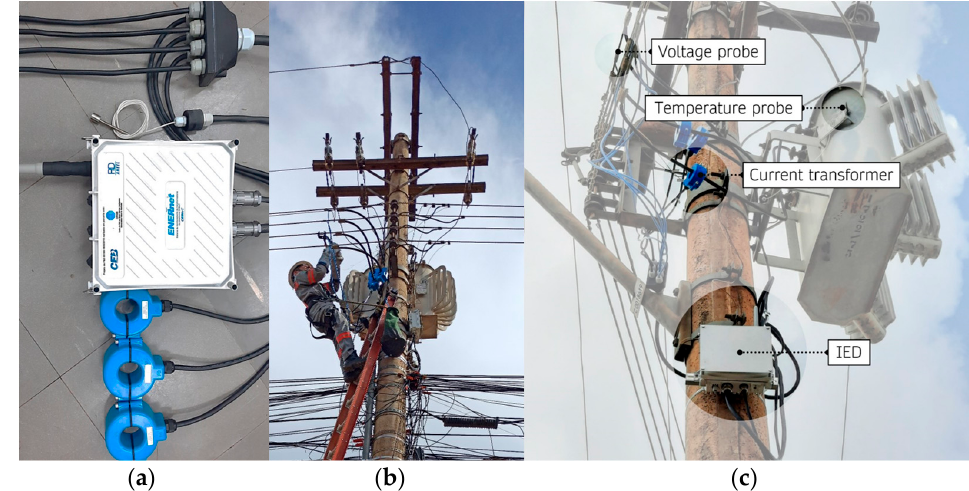
Figure 1. Monitoring system of distribution transformers used to perform basic electrical and thermal measurements of the transformer. ( a ) IED (intelligent electronic device). ( b ) Non-intrusive installation process. ( c ) Distribution transformer real-time monitoring by the IED. Table 1. Specifications of IED.